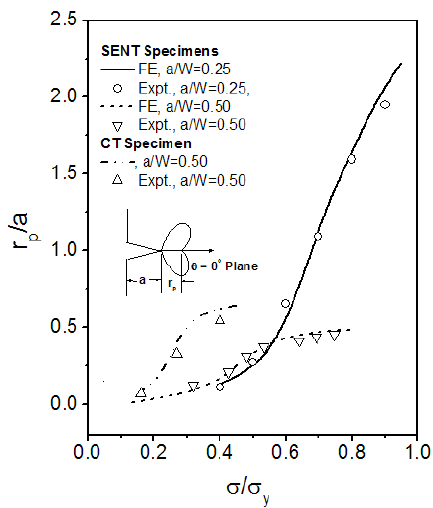
Figure 7: Variation normalized plastic zone size (r p /a) estimated by microhardness technique and FEA vs . normalized applied stress ( σ / σ y ) in SENT and CT